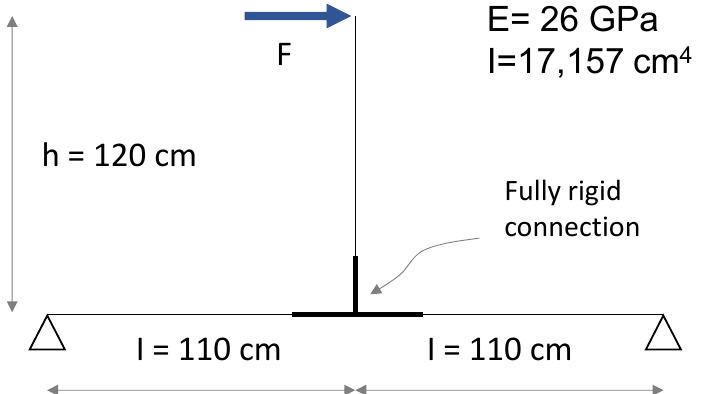
Figure 11. Load–displacement response of T1 and T2_W specimens tested in static loading conditions.